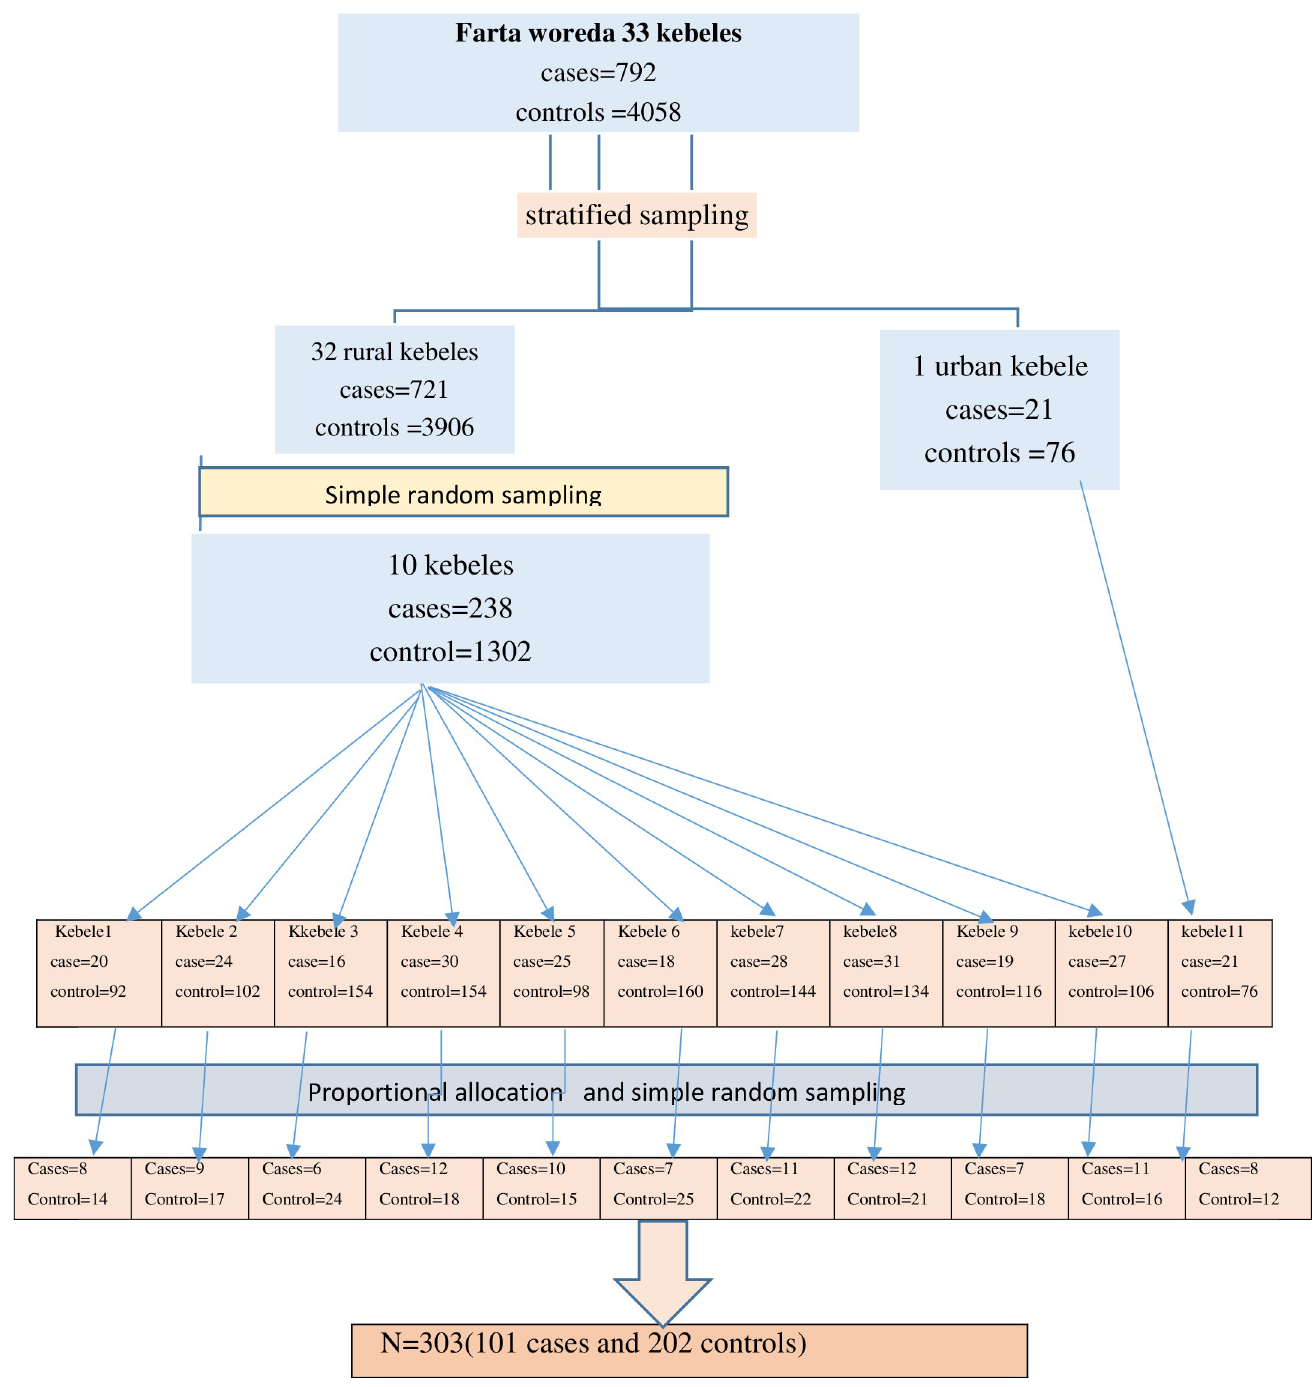
Fig 1. Sampling procedure of short birth interval practice among reproductive age women in Farta woreda, south Gondar zone, North West Ethiopia, 2019.